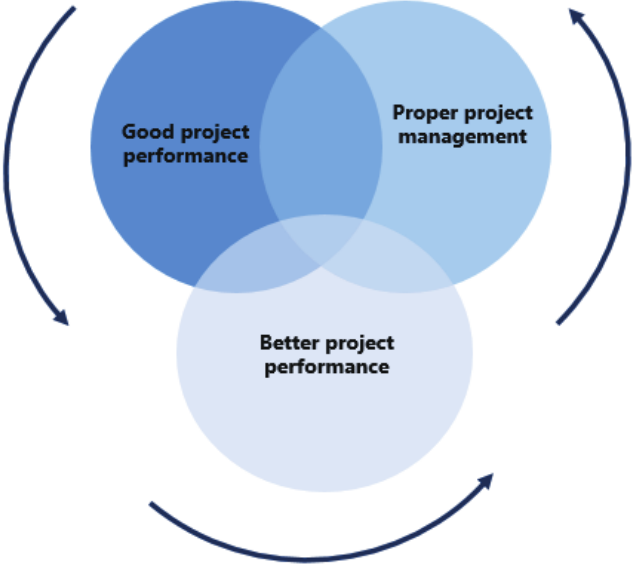
Fig. 1. Theoretical relationship of the research (Adapted from Abednego & Ogunlana,